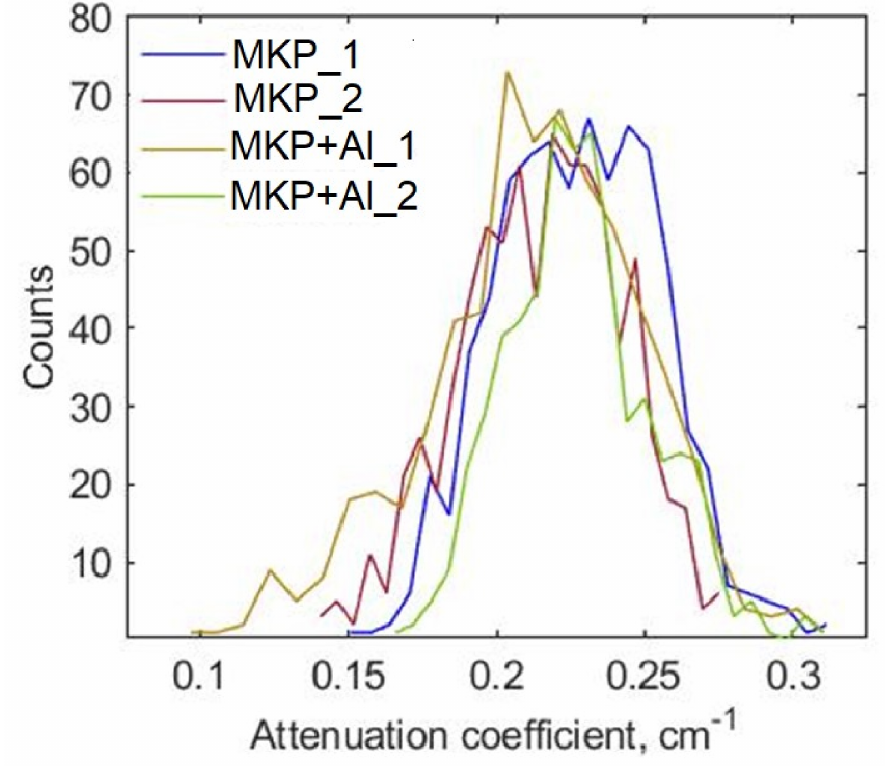
Figure 4. Distributions of the minimum gray values at the boundary between the samples and air calculated over the stack of the tomography slices.